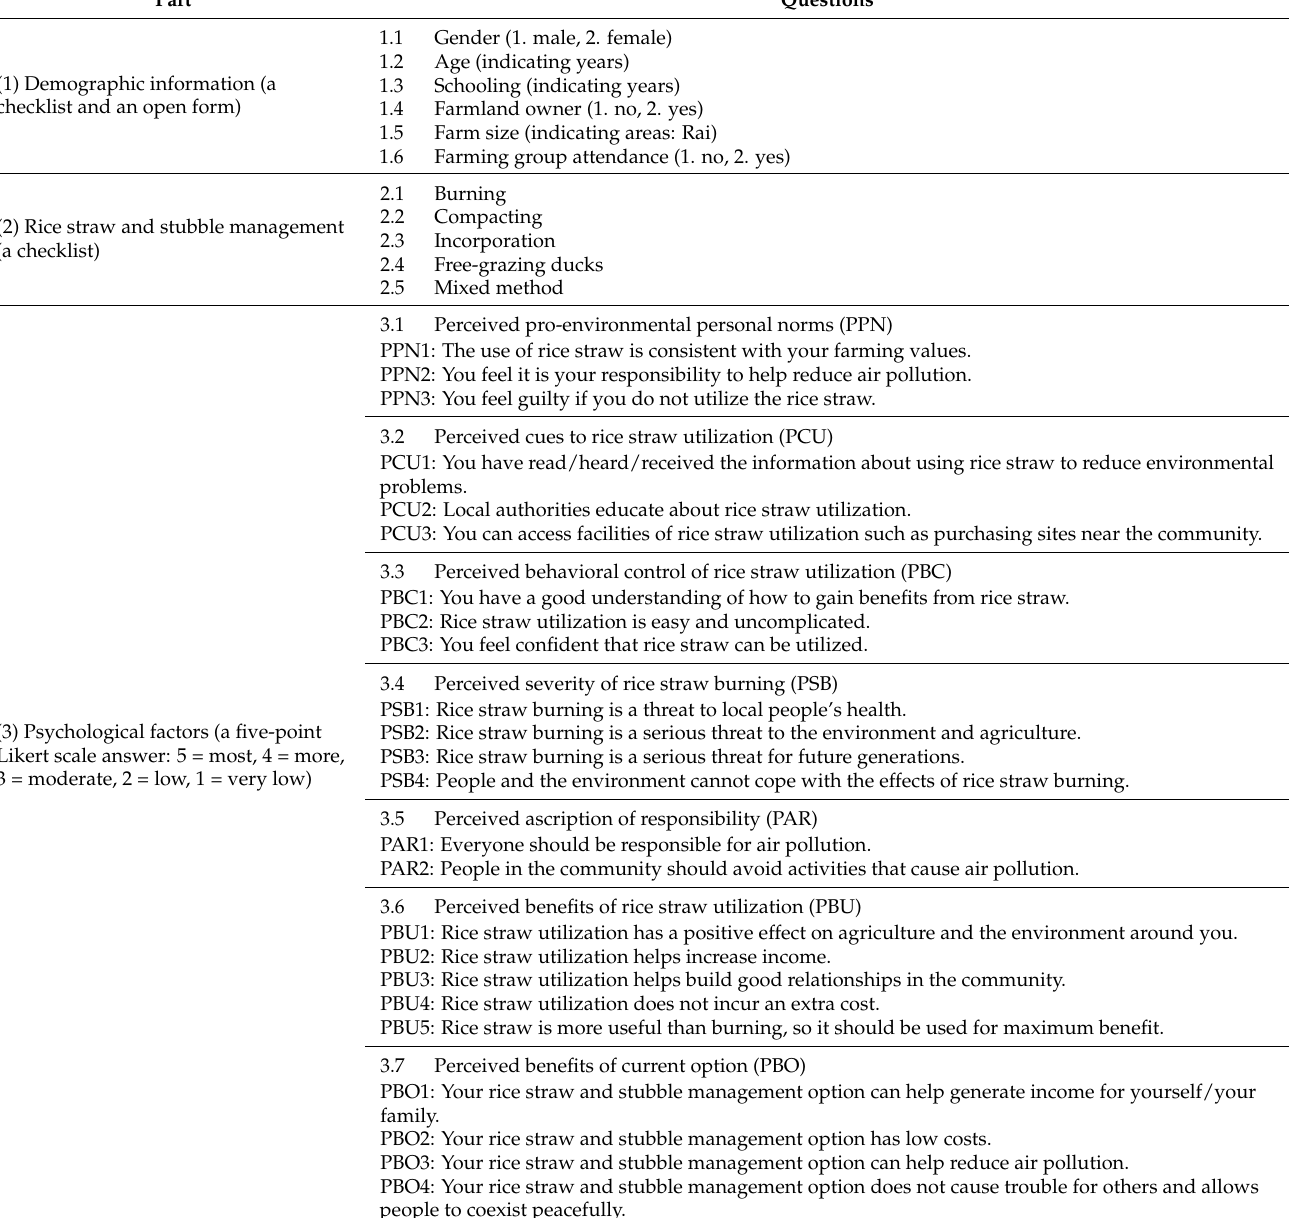
Table 2. The questions used in the questionnaire to ask